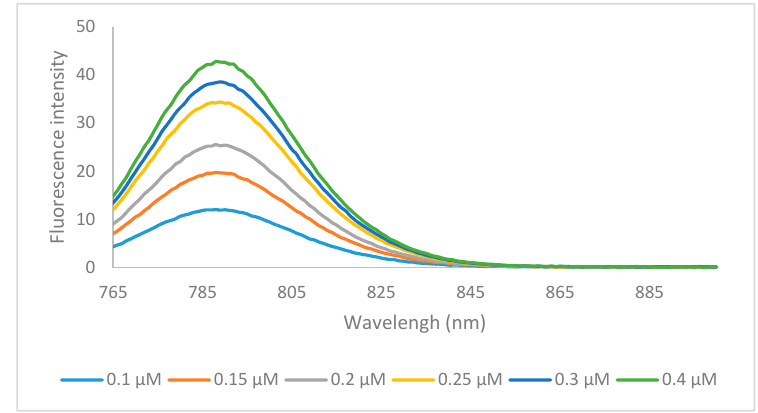
Figure 3. Emission spectra of dye 6m in ethanol with excitation wavelength of 750 nm.